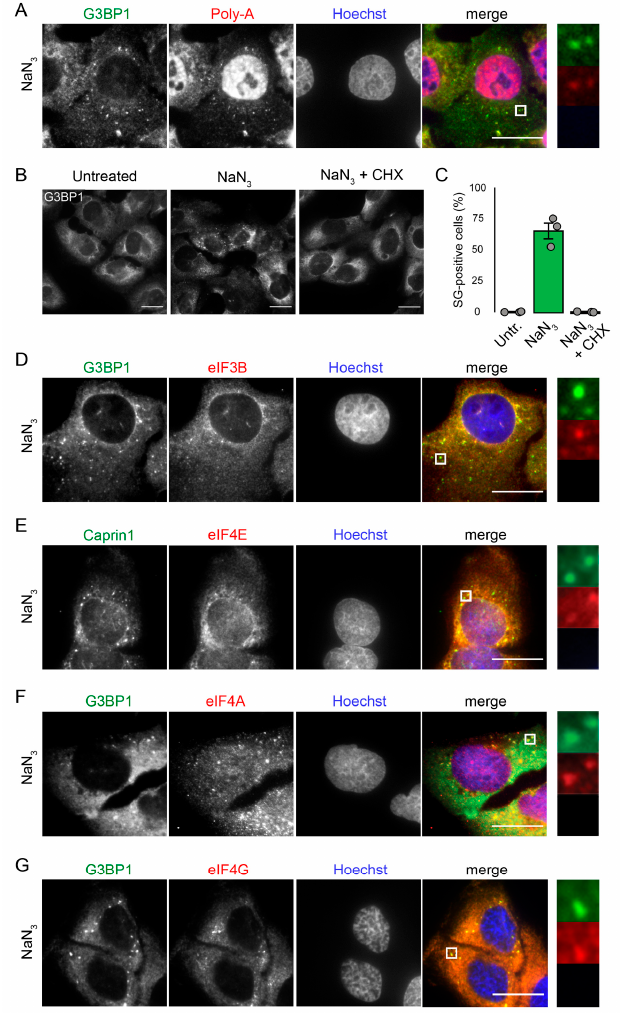
Figure 2. Detailed characterization of NaN 3 -induced SGs. ( A ) Fluorescence in situ hybridization with an oligo-(dT) probe was used to visualize mRNA in U2OS cells that were treated with NaN 3 (76 mM) for 1 h. Cells were stained with anti-G3BP1 antibody. Subcellular localization of G3BP1 was used for the detection of SGs; Scale bar = 20 µ m. ( B ) Cells were left untreated, treated with NaN 3 (76 mM), or CHX and NaN 3 in combination. ( C ) A quantification of SG-positive cells in B is presented. The graph shows the mean value ± SD ( n = 3 independent experiments; approximately 100 cells were analyzed per experiment and condition). ( D ) Co-immunostaining of eIF3B and G3BP1 in U2OS cells treated with NaN 3 ; Scale bar = 20 µ m. ( E ) Co-immunostaining of Caprin1 and eIF4E in U2OS cells treated with NaN 3 ; Scale bar = 20 µ m. ( F ) Co-immunostaining of eIF4A and G3BP1 in U2OS cells treated with NaN 3 ; Scale bar = 20 µ m. ( G ) Co-immunostaining of eIF4G and G3BP1 in U2OS cells treated with NaN 3 ; Scale bar = 20 µ